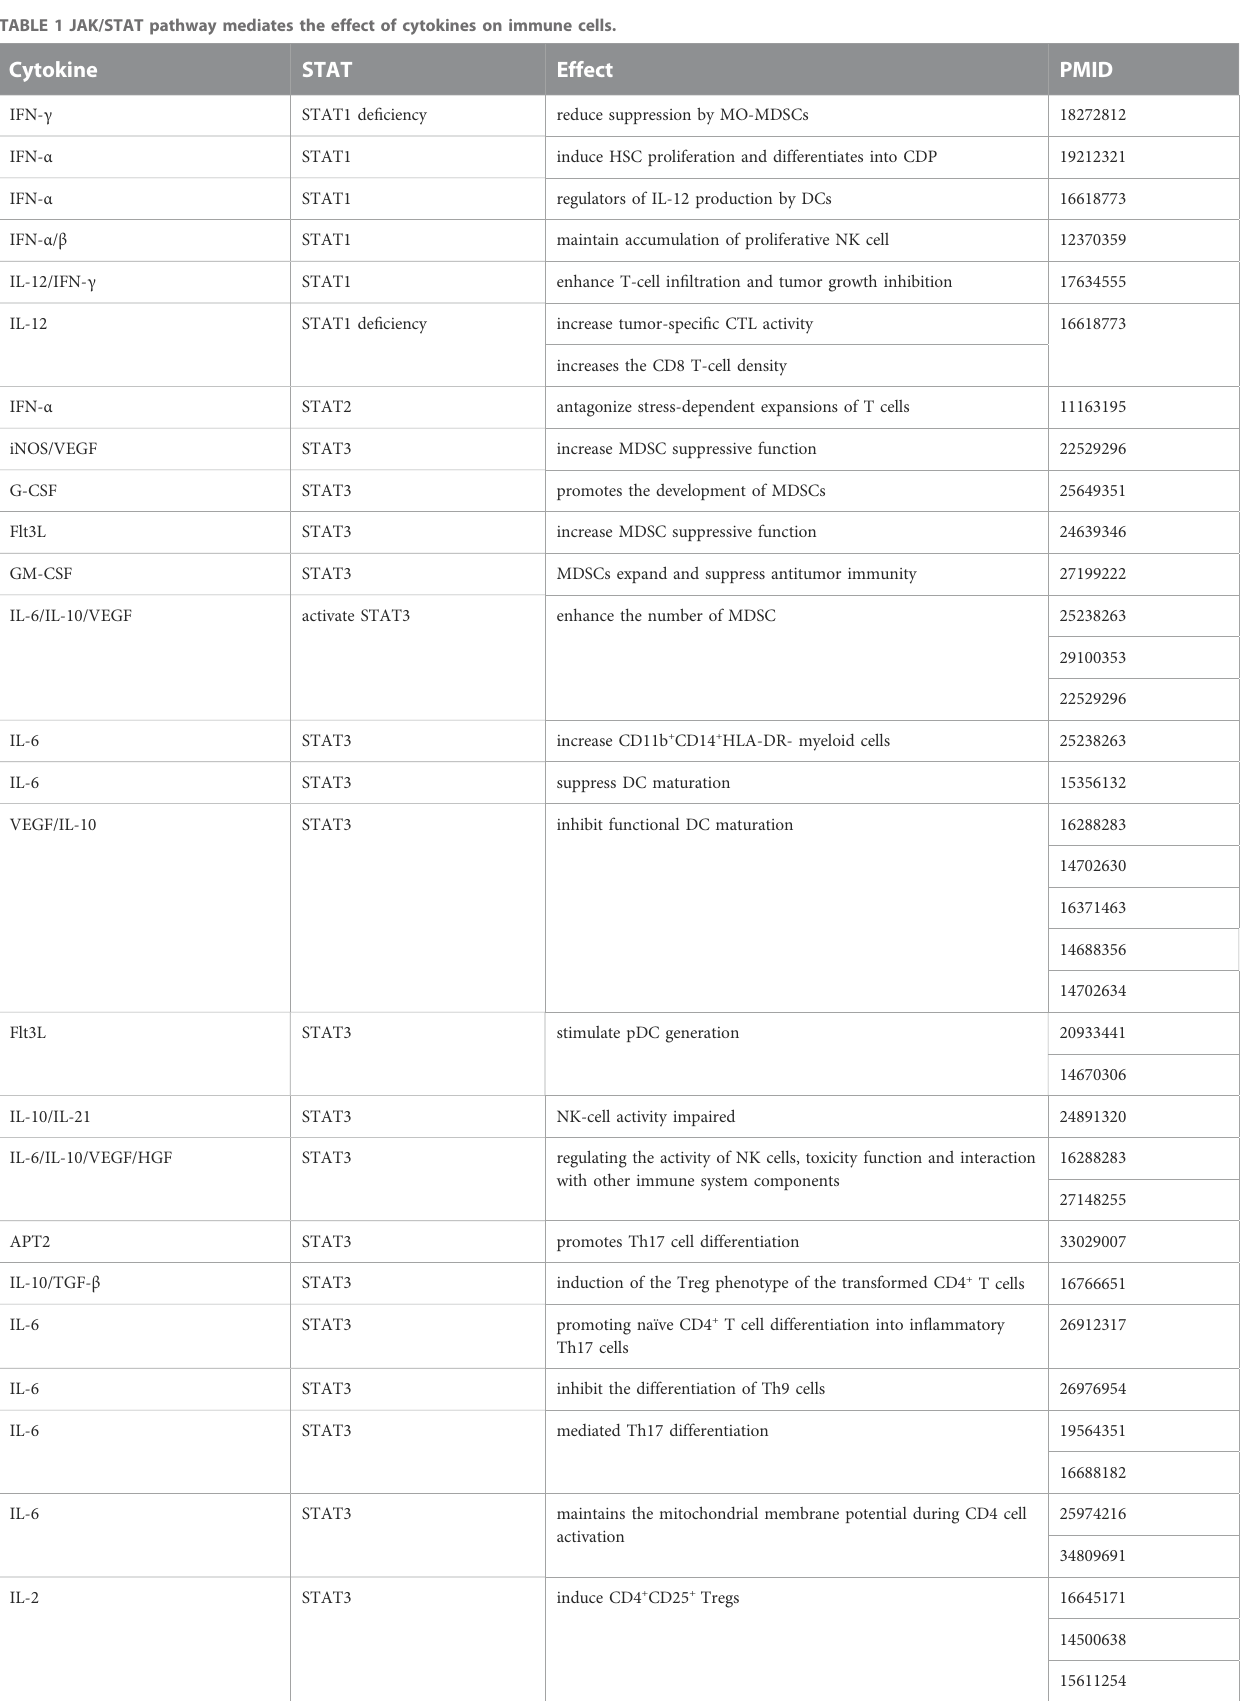
TABLE 1 JAK/STAT pathway mediates the effect of cytokines on immune